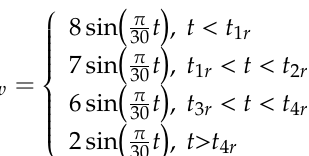
Figure 7. Simulation results of the conventional PI controller and the proposed ATSFMPC scheme in Northwest European shelf. ( a ) Power coefficient response; ( b ) DC-link output voltage; ( c ) d-q axis output voltage; ( d ) turbine power in ATSFMPC method. Table 2. Comparison of DC-link voltage regulation performances for Northwest European shelf.